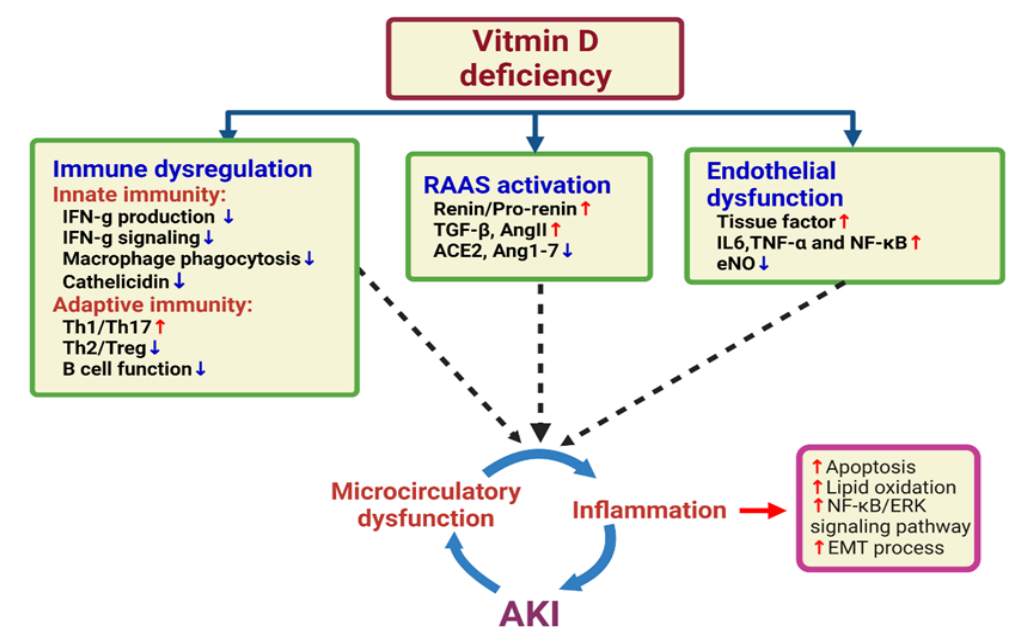
Figure 1. Integrated hypothesis of the association between vitamin D deficiency and acute kidney injury (AKI). Vitamin D deficiency may trigger innate and adaptive immune disorders, RAAS hyperactivity, and systemic and glomerular capillary endothelial dysfunction. All of these factors lead to direct kidney cell injury, microcirculatory dysfunction, excessive inflammation, and even macrophage activation syndrome or cytokine storms, which are key factors in the development of acute kidney injury.